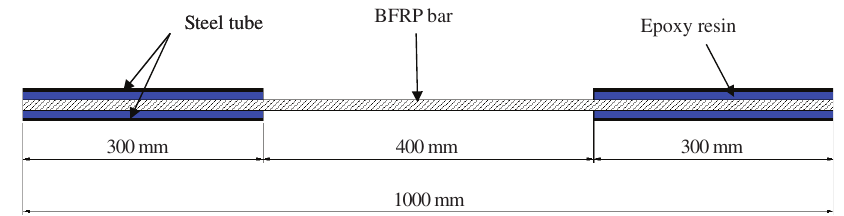
Figure 3: Tension test